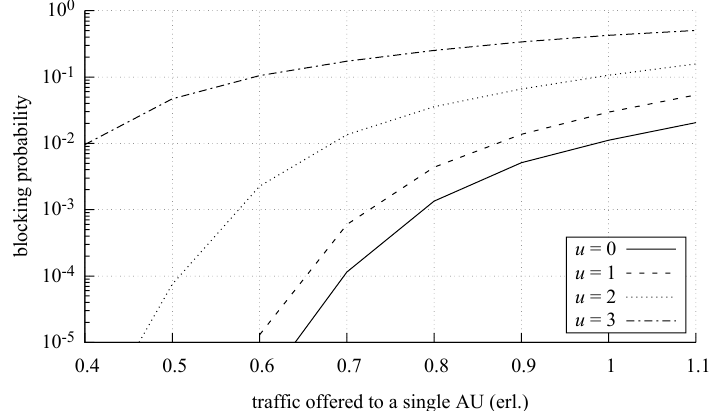
Figure 11. Blocking probability for class 2 calls in relation to the number of deactivated switches ( u parameter).